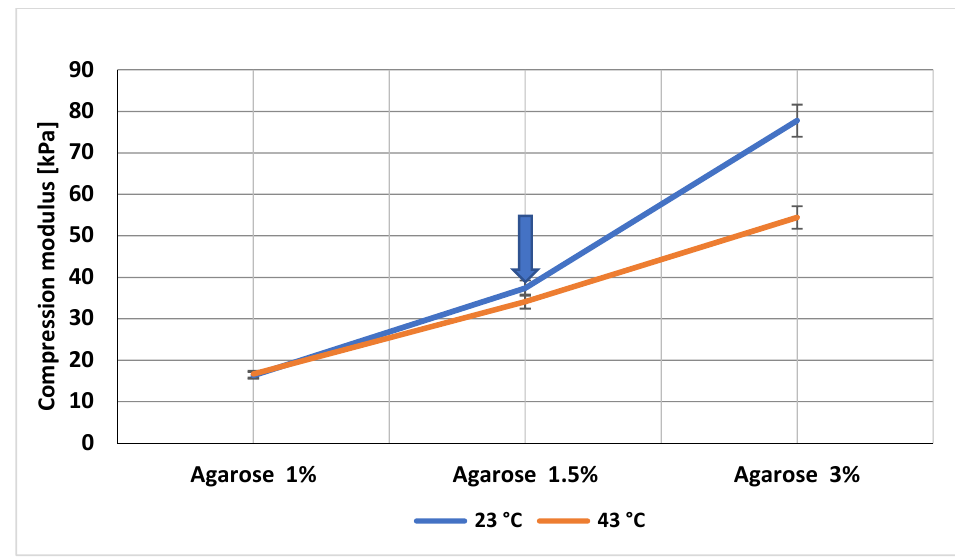
Figure 6. Dependence of the Young’s modulus of elasticity on agarose concentration.